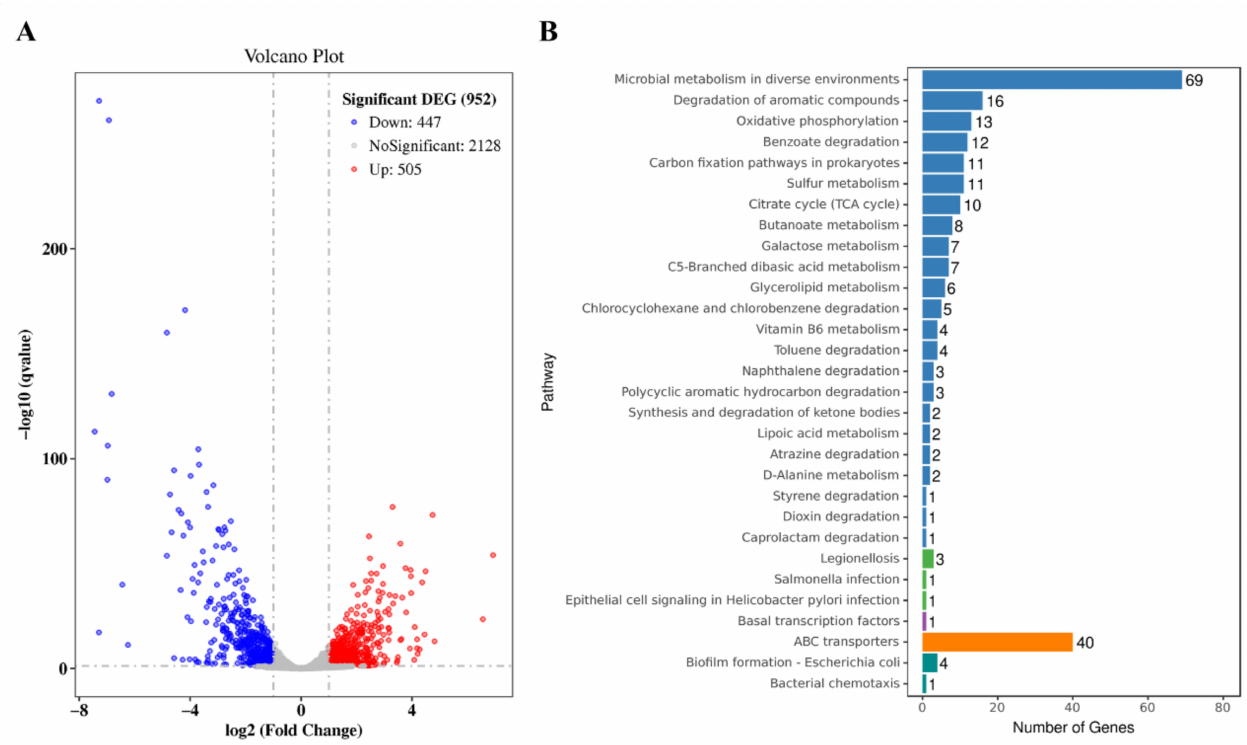
Figure 3. Changes in overall gene transcription levels and enrichment of KEGG pathways according to the whole-transcriptome sequencing data. ( A ) A volcano plot of the DEGs. Red and blue dots, respectively, indicate significantly up- and downregulated DEGs; horizontal coordinates represent gene expression fold changes in different samples; and vertical coordinates represent the statistical sig- nificance of differences in gene expression. ( B ) Significantly enriched KEGG annotated classification. Blue bars represent metabolism; light green bars represent human diseases; purple bars represent genetic information processing; orange bars represent environmental information processing and dark green bars represent cellular processes. The vertical axis indicates the pathway name, and the horizontal axis indicates the number of